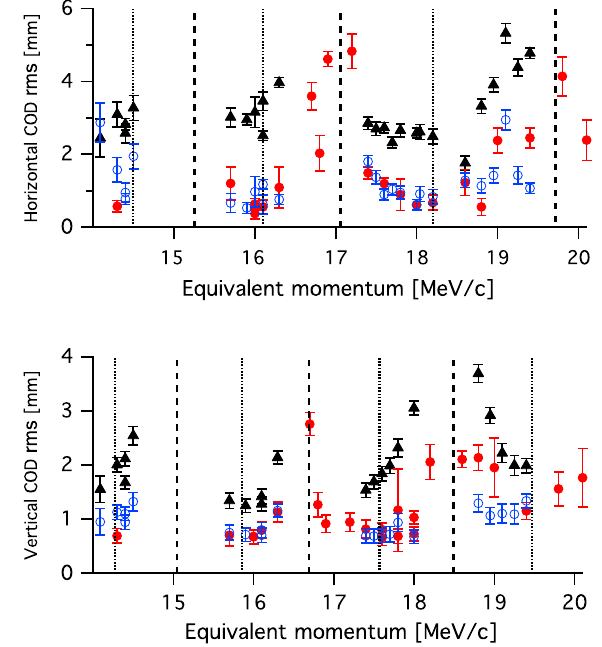
FIG. 9. The rms of COD over the momentum range in EMMA measured before (black triangles) and after (red filled circles) correction in the horizontal (top panel) and vertical (bottom panel) planes. At each momentum, the closed orbit is found at BPMs symmetrically located in between each quadrupole doublet and the rms of the resulting COD calculated. The predicted COD is also shown (blue open circles). The momenta at which the tune is integer and half integer, in the corresponding transverse plane, is shown by the vertical dashed and dotted lines, respectively. These values are obtained by fitting the tunes measured at various points over the momentum range by an interpolating function.